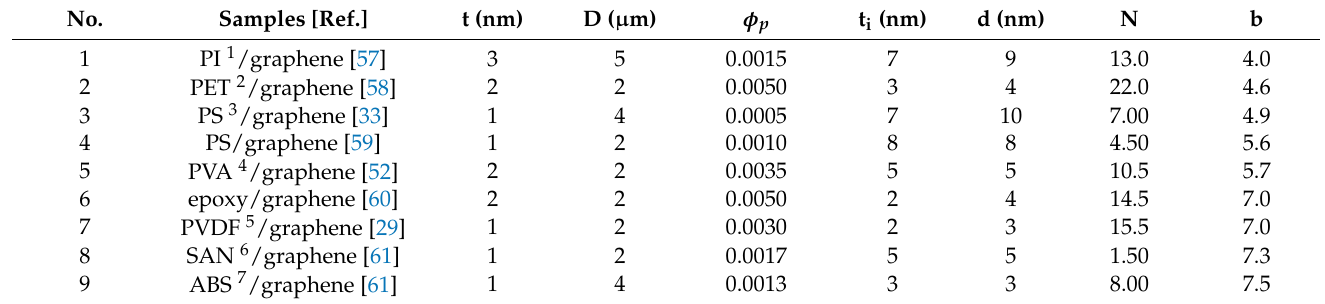
Table 1. Selected examples and the outputs of numerous terms by the equations.